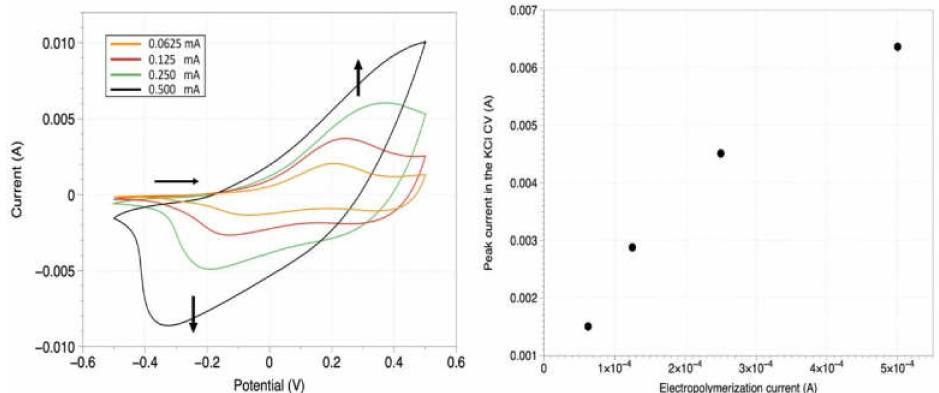
Figure 3. On the ( left ) panel, cyclic voltammetry (CV) curves recorded on PANI/Au WEs. The various colors are associated with separate samples that underwent different currents of electropoly- merization, leaving all the other parameters unaltered (electrochemical bath, electropolymerization time of 900 s, substrate, electrode area, etc.). Orange curve : PANI electropolymerization at 0.0625 mA for 900 s; red curve : PANI electropolymerization at 0.125 mA for 900 s; green curve : PANI elec- tropolymerization at 0.25 mA for 900 s; black curve : PANI electropolymerization at 0.5 mA for 900 s. These samples were tested by CV between − 0.5 V and 0.5 V vs. Ag/AgCl/KCl sat ; Pt was the counter-electrode. The solution only consists of the support electrolyte: KCl (0.1 M). The scan-rate is 0.1 V/s. On the ( right ) panel: relation between the peak oxidation current recorded in the previous CVs (on the ( left ) panel) and the value of the imposed current during the electropolymerization of the samples.